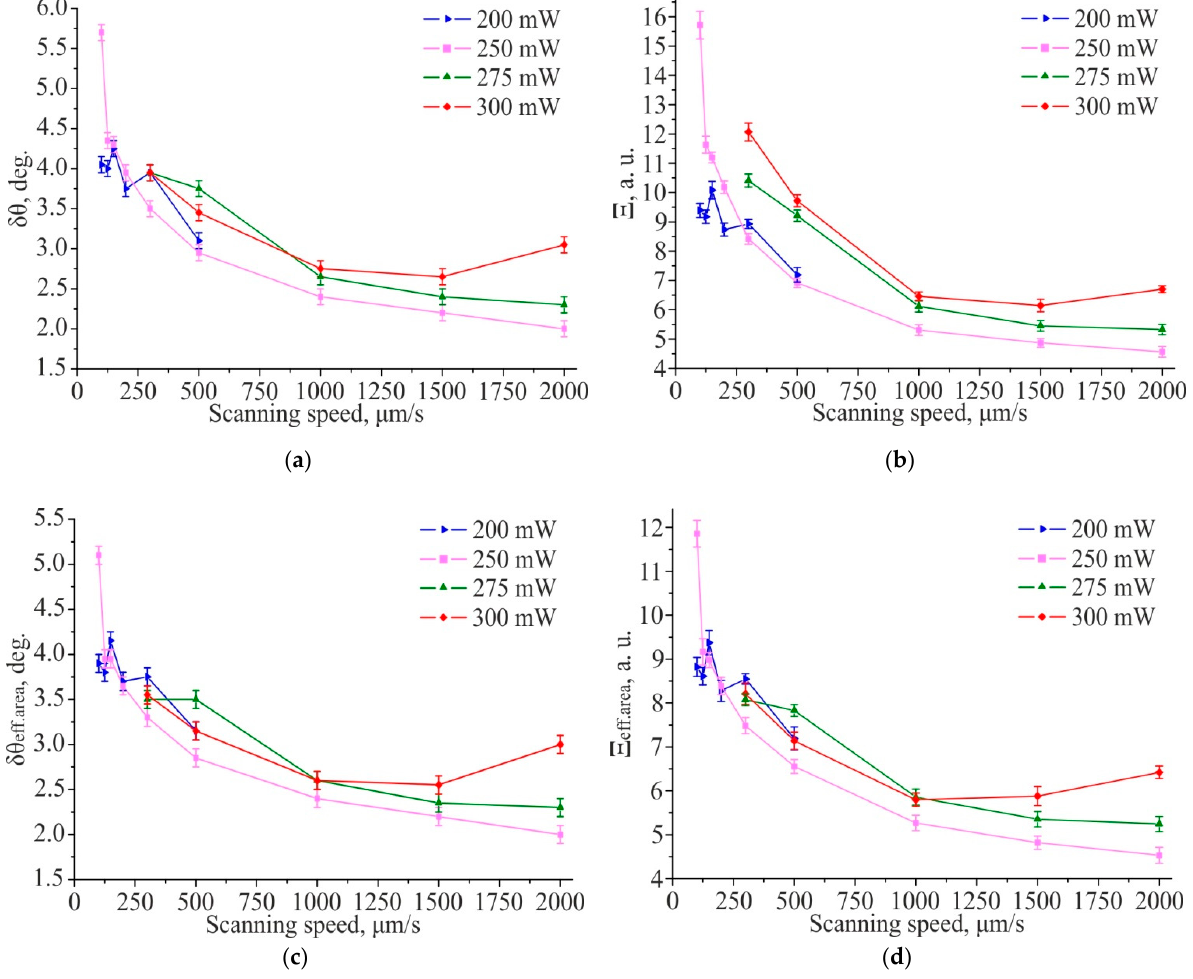
Figure 6. Dependences of the structures straightness δθ ( a ) and the structures parallelism Ξ parameters ( b ) for TLIPSS formed on a hafnium film in air at different scanning speeds and laser powers, corresponding values for δθ eff.area ( c ) and Ξ eff.area ( d ).